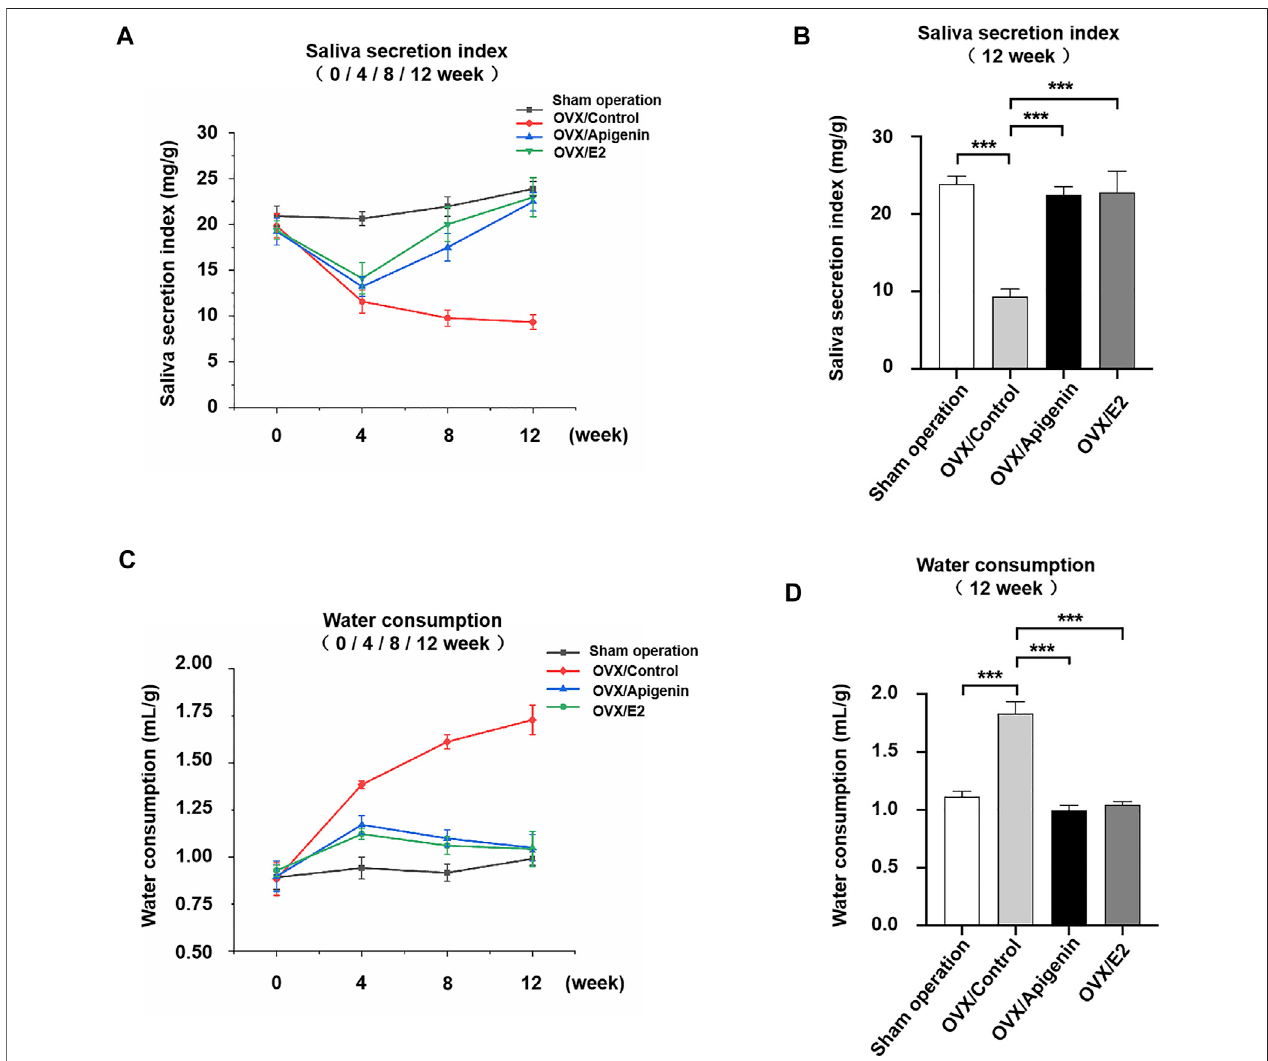
FIGURE 6 | Apigenin ameliorates the impairment of saliva secretion and reduced the water consumption rate in OVX mice. (A) Salivary secretion index before ovariectomy and after 4, 8, and 12 weeks of treatments. (B) Salivary secretion index after 12 weeks of treatment. (C) Water consumption rate before ovariectomy and after 4, 8, and 12 weeks of treatments. (D) Water consumption rate after 12 weeks of treatment. Data are presented as the mean ± SD, n = 6. Signi fi cant effect of the treatment, * p < 0.05, ** p < 0.01.